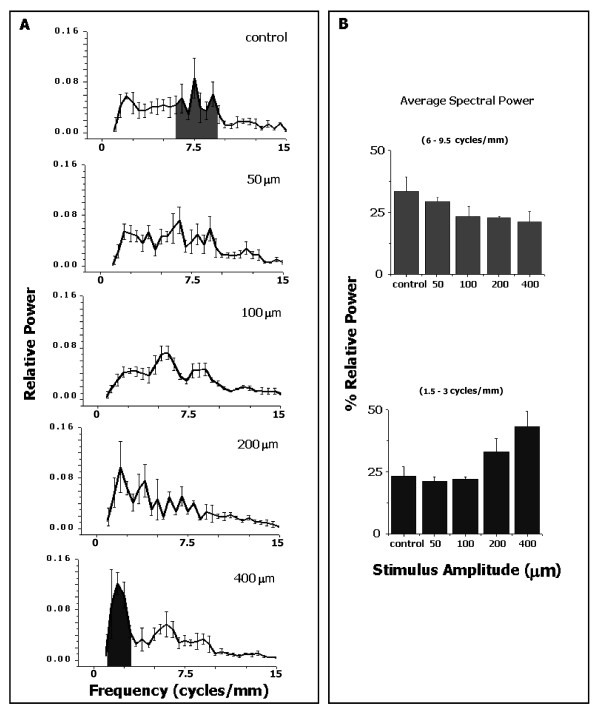
Across-subject reproducibility of the effect of flutter stimulus amplitude on the power spectra of the data sampled in the A-P dimension. A: Average periodograms of the OIS responses of 5 subjects to 5 different stimulus amplitudes. B: Average relative power in the 6–9.5 cycles/mm and 1.5–3 cycles/mm frequency bands plotted as a function of the stimulus amplitude. As the stimulus amplitude increases, the spectral power shifts progressively to lower spatial frequencies.